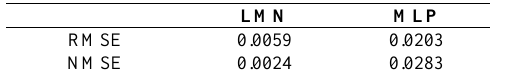
Table 2. Results of longitudinal velocity identification.